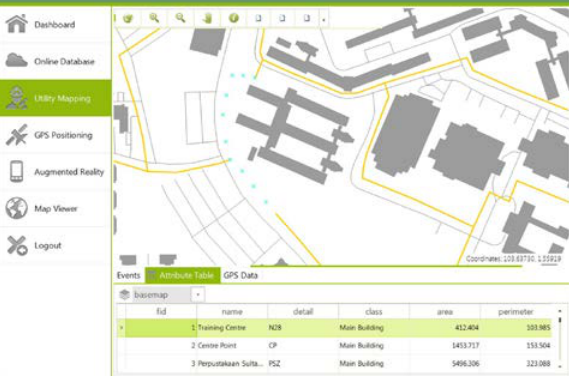
Figure 8. Newly added coordinates (points) are shown as X sign (cyan